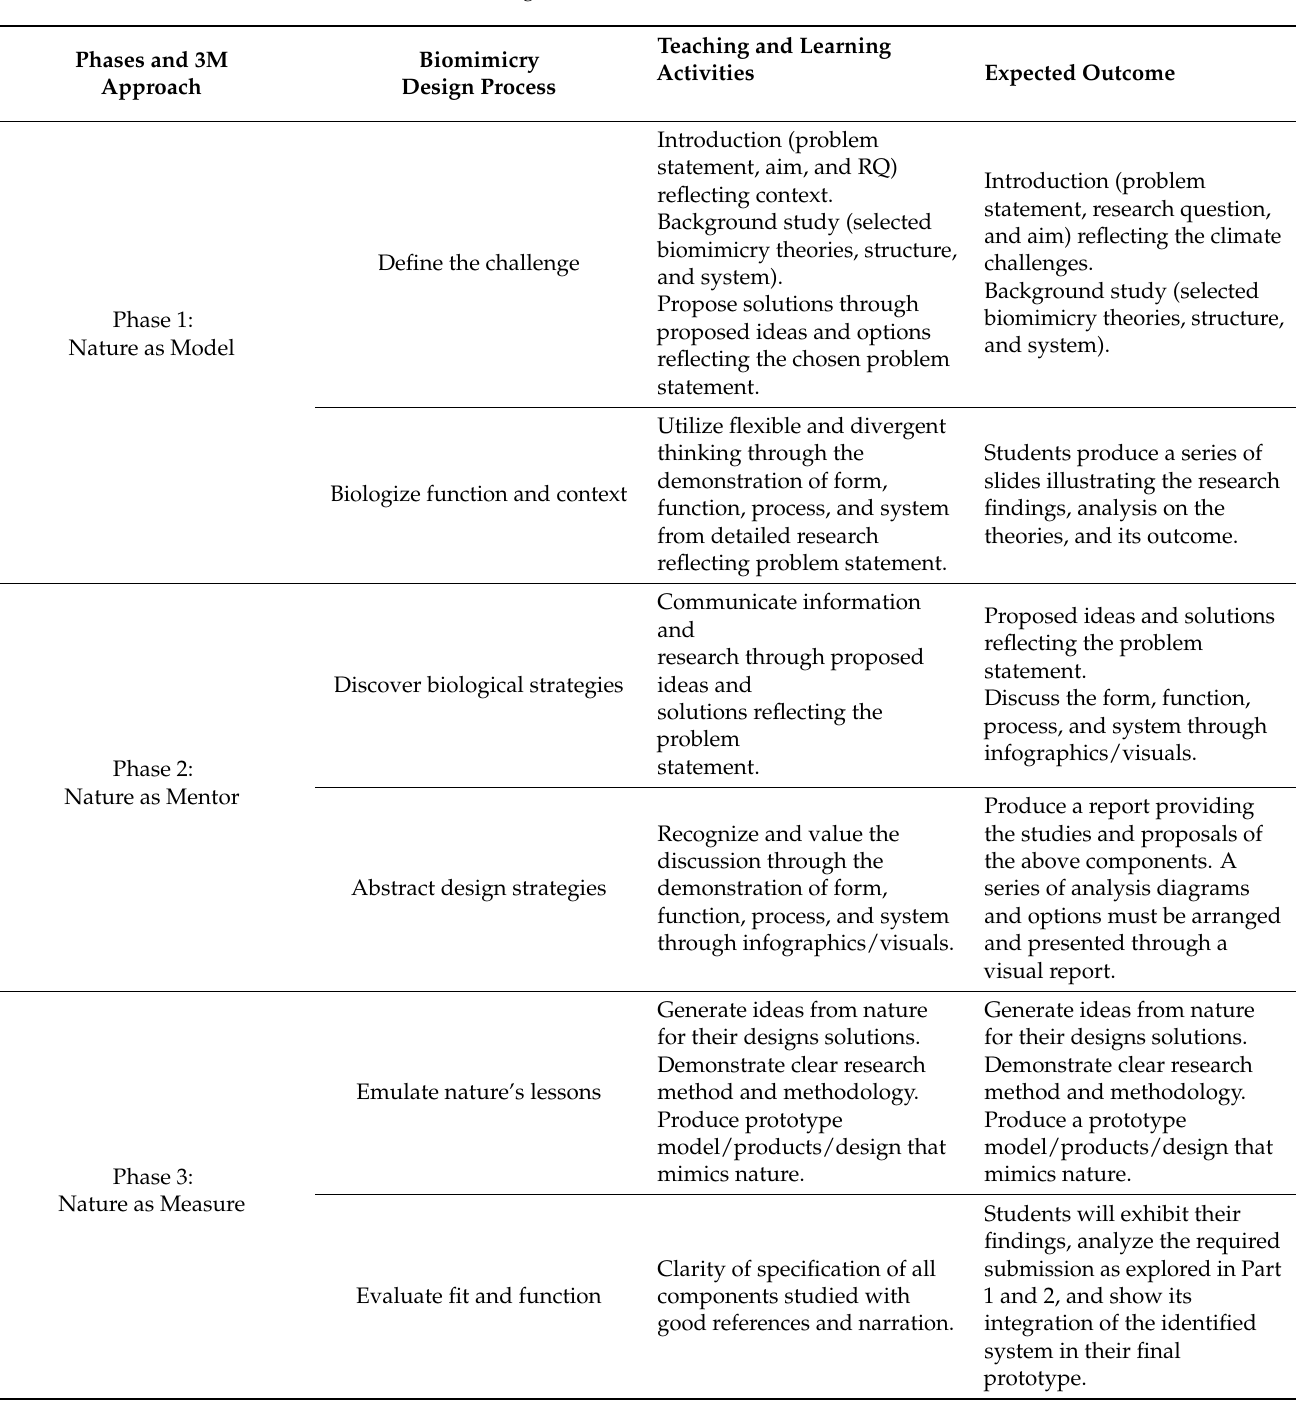
Table 1. Relationships between biomimicry design process (based on [3]) and teaching/learning activities and learning